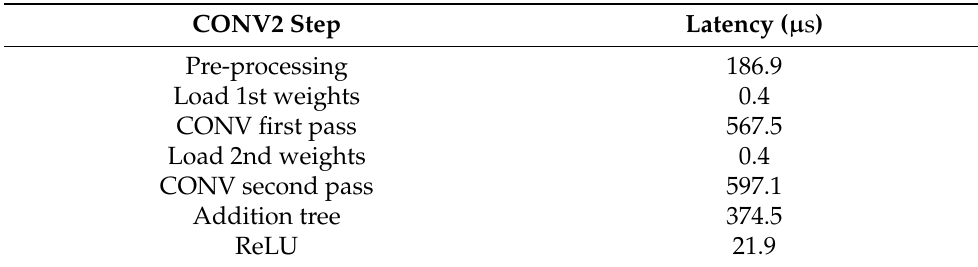
Table 3. A breakdown of the latency for each step required to perform the second convolutional layer. A clock frequency of 100 MHz is